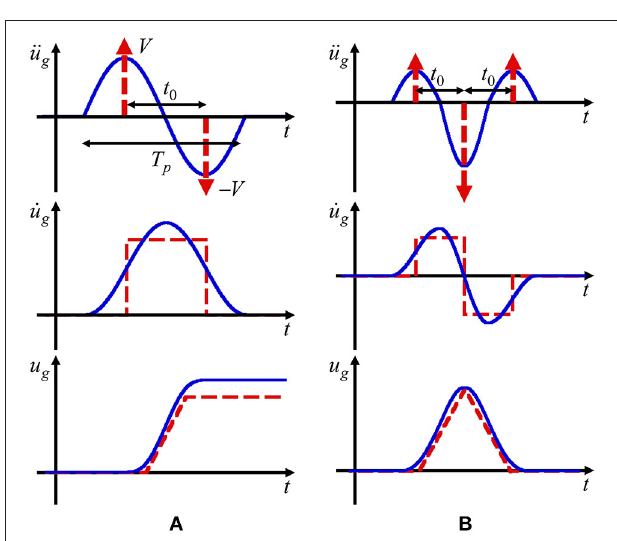
FIGURE 2 | Modeling of main part of near-fault ground motion, (A) Fling-step and double impulse, (B) Forward-directivity and triple impulse, Kojima and Takewaki